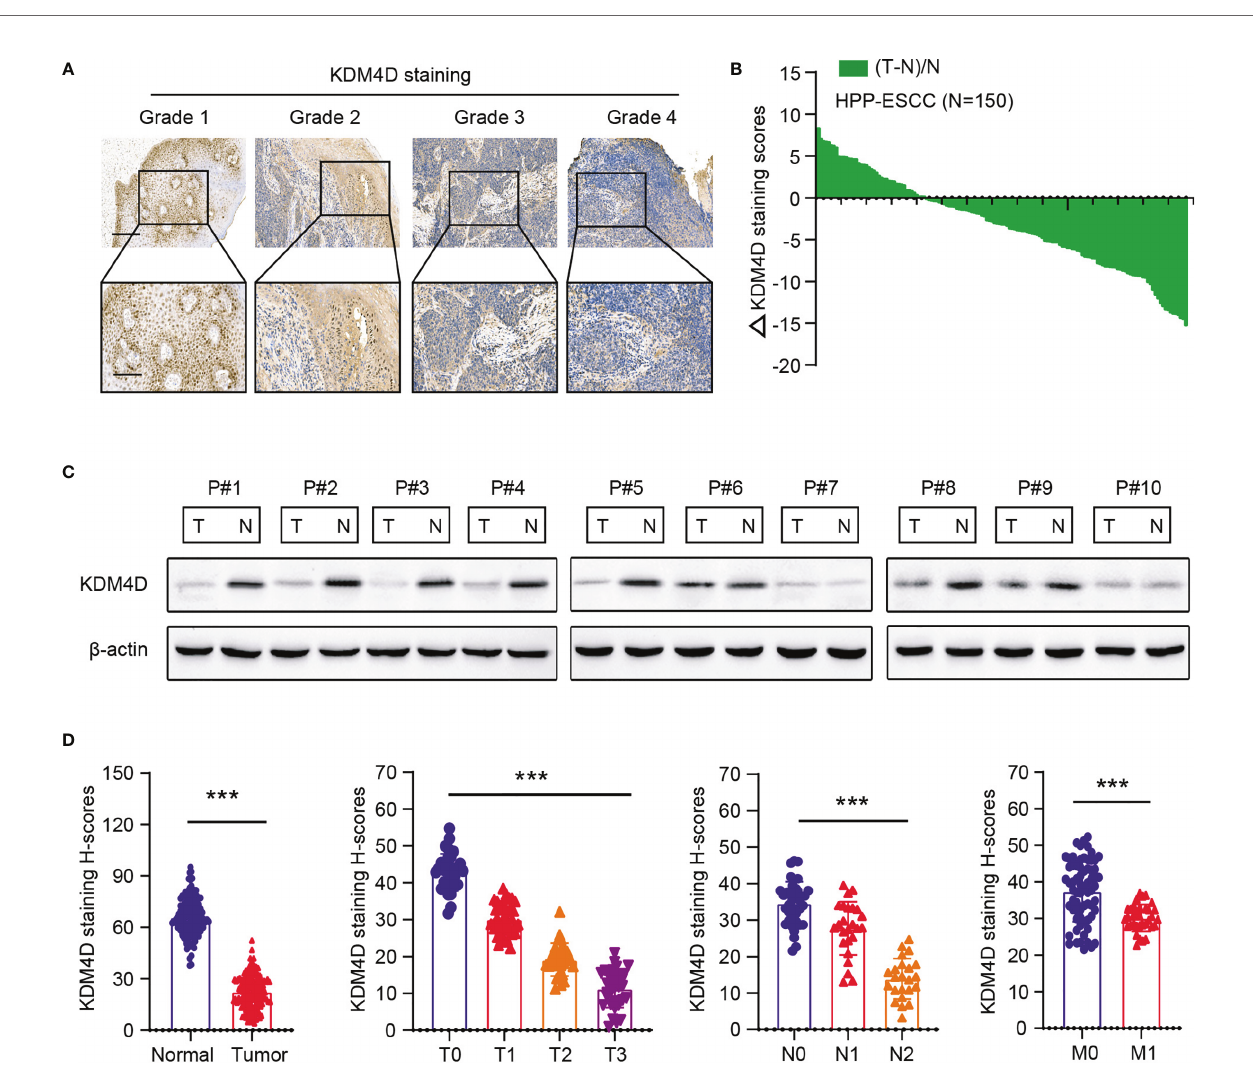
FIGURE 2 | Validation of expression levels and clinical signi fi cance of KDM4D in ESCA. (A) Representative IHC graphs in ESCC samples with different grades. (B) Quanti fi cation of the H-scores of KDM4D staining in HPP-ESCC cohort. Scale bar = 200 m m (upper) and Scale bar = 80 m m (lower). (C) KDM4D protein levels were detected in ESCC tissues and paired normal tissues via western blotting (n = 10). (D) Correlation analysis of KDM4D protein levels with clinical characteristics in HPP-ESCC cohort. * P < 0.05, ** P < 0.01, *** P <